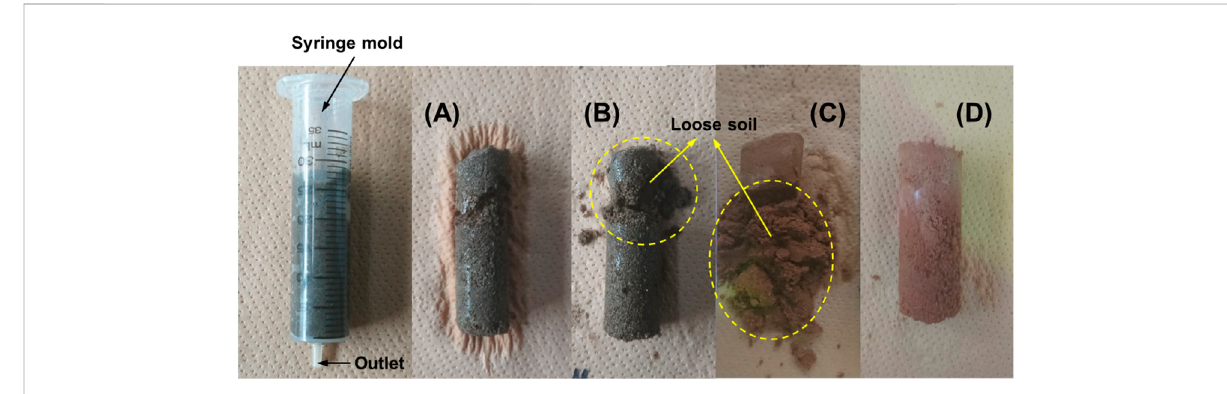
FIGURE 6 Physicalappearanceofthe (A) MICPtreated fi nesand(Onuma), (B) B-EICPtreated fi nesand(Onuma), (C) MICPtreatedsiltysand(Watsu)and (D) B-EICP treated silty sand